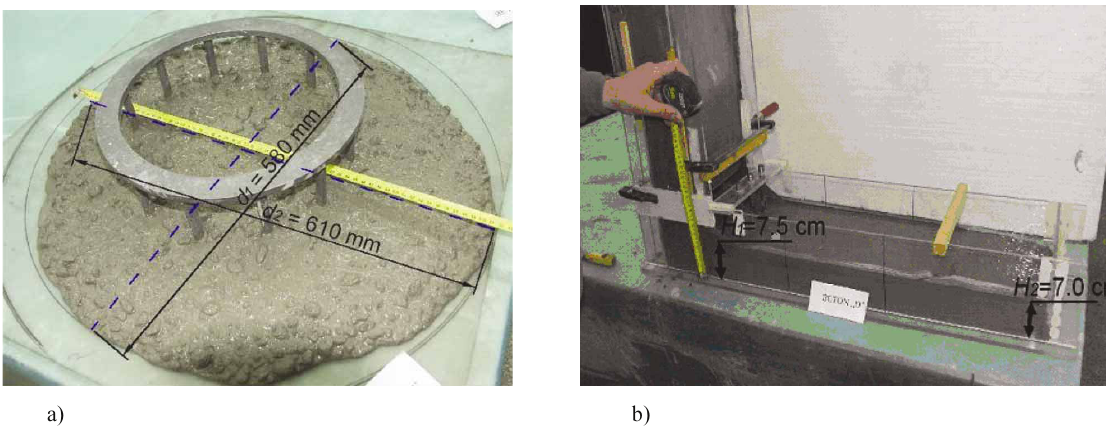
Fig. 1. Spread test results for: a) concrete mix A/SA (J-Ring); b) concrete mix D/SV (L-Box)